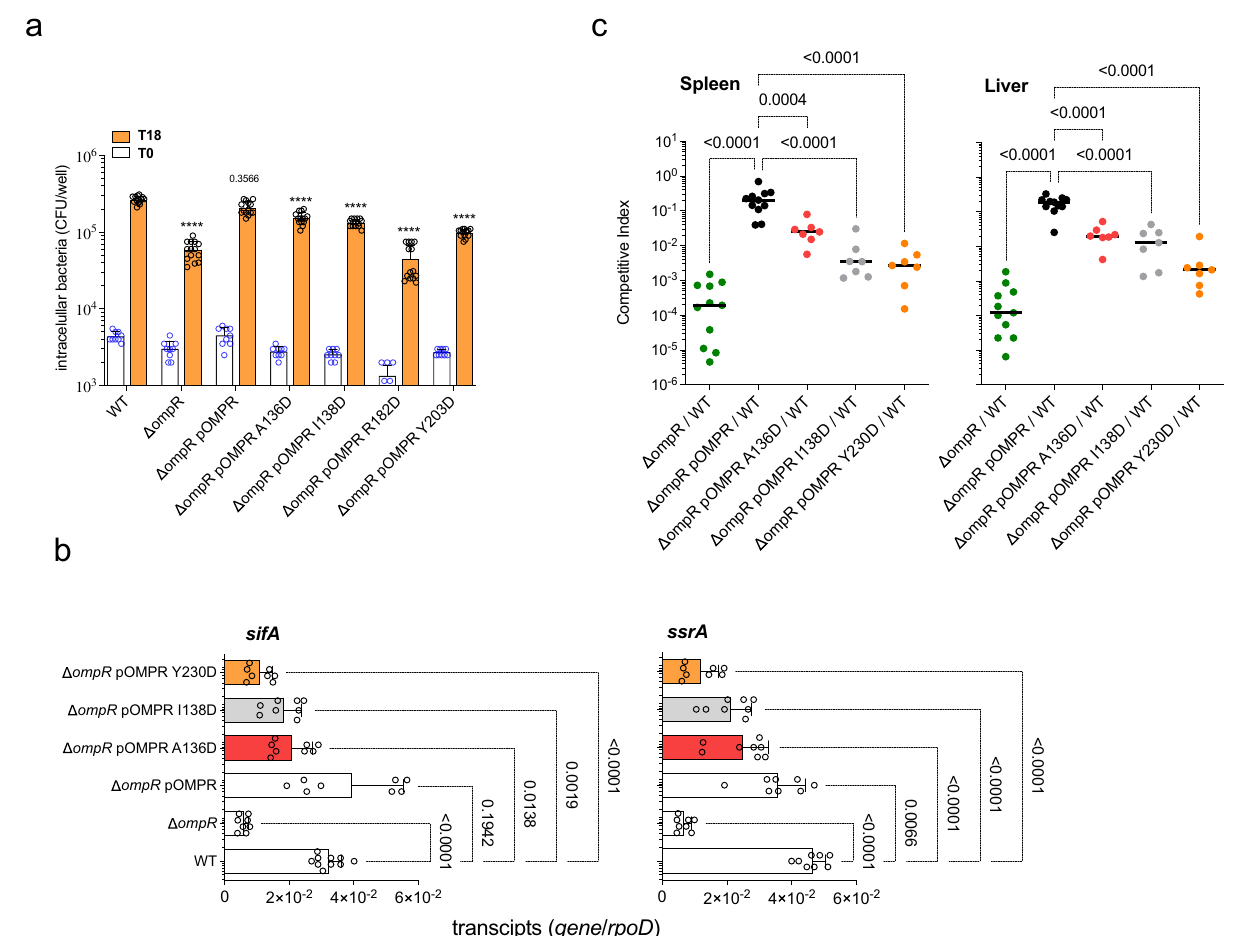
Fig. 7 | OmpR interfacial residues mediating binding to TrxA contribute to Salmonella pathogenesis. a Intracellular replication of the indicated Salmonella strains was evaluated by recording CFU at times 0 and 18h after infection of J774 cells at an MOI of 2. The data are mean±SD (T0; n =9, T18; n =14 biological replicates). **** p <0.0001 as estimated by two-way ANOVA with Sidák ’ s multiple test correction. b The abundance of SPI-2 transcripts in RNA specimens isolated fromJ774cells8hafterinfectionwith Salmonella atanMOIof50wasquanti fi edby qRT-PCR. The results are normalized to internal levels of the housekeeping gene rpoD .Thedataarethemean±SD( sifA , n =10,8,8,8,8,8; ssrA , n =8).Exact p values